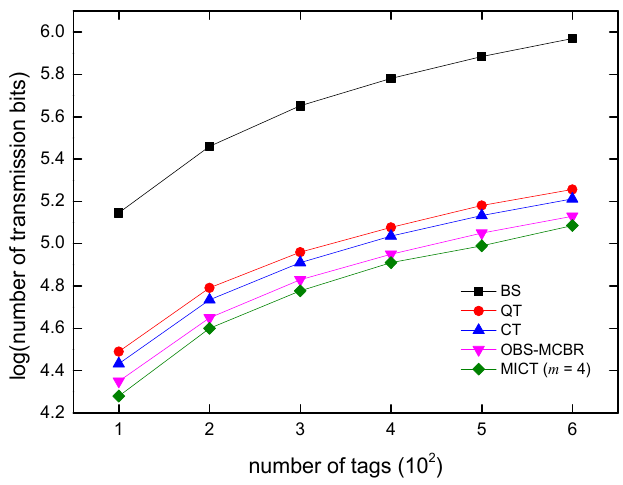
Figure 10. Comparison of query cycles.